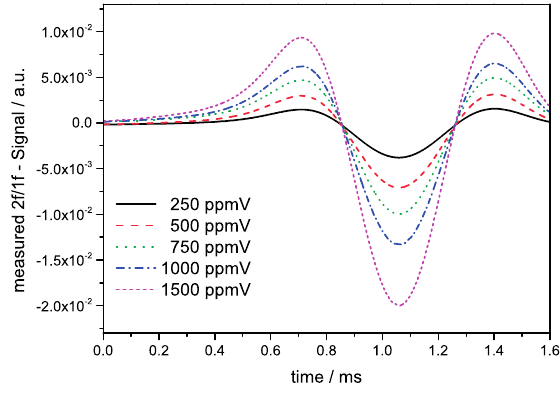
Figure 9. Time series measurement of reference spectra at 750 ppmV over 60 min to assure stability, where the 2f-amplitude is color coded. Below a single corresponding WMS-2f scan is shown. The measurement was performed at 125 Hz. But only three scans per second were saved to save computer memory. The achieved standard deviation of the peak WMS-2f signal was 5.2 × 10 − 5 V rms